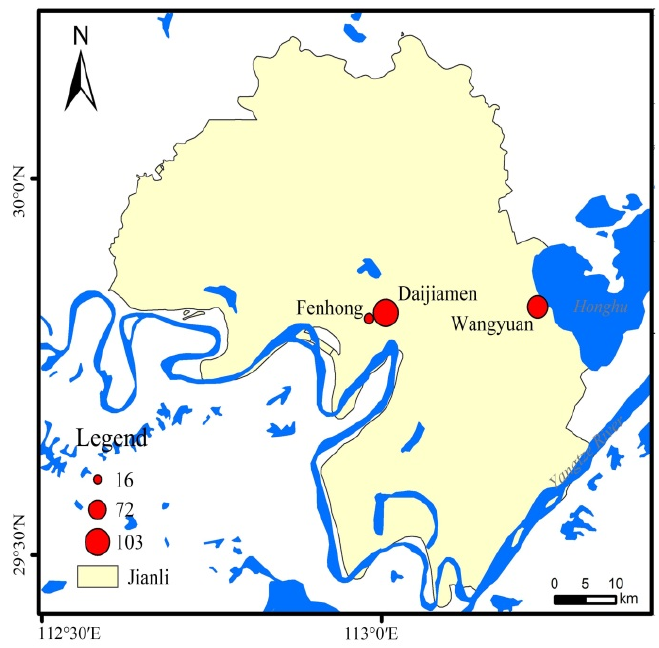
Figure 1. The Distribution of Study Area .